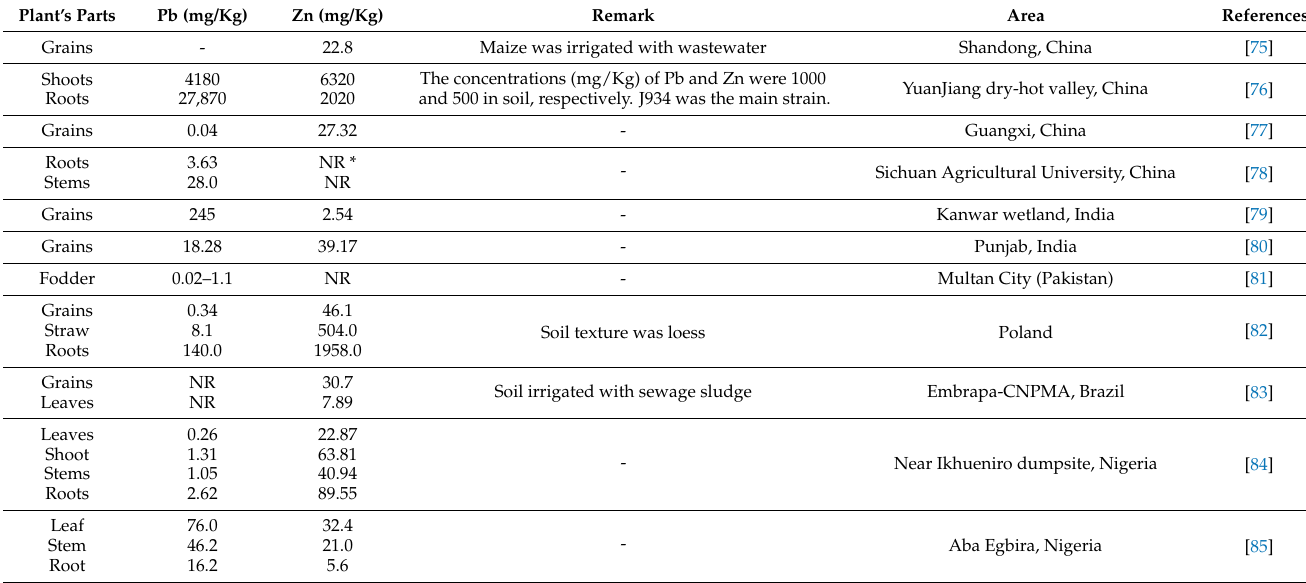
Table 2. Pb and Zn reported in